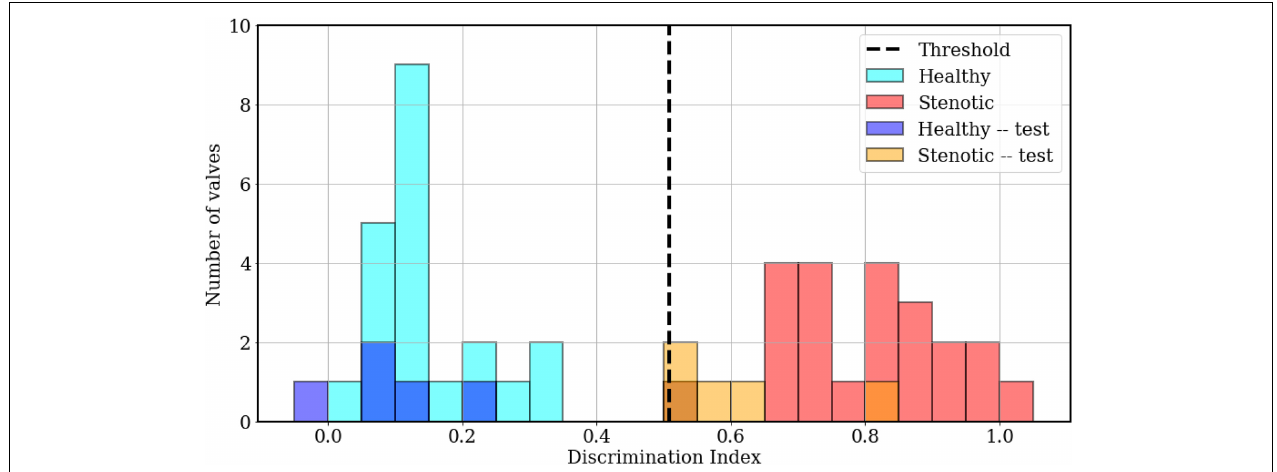
FIGURE 10 | Histogram plots showing classification results, computed as LDA projection values of individual simulations from the training (cyan, red) and test (blue, orange) sets, relative to the threshold value (dashed black line).